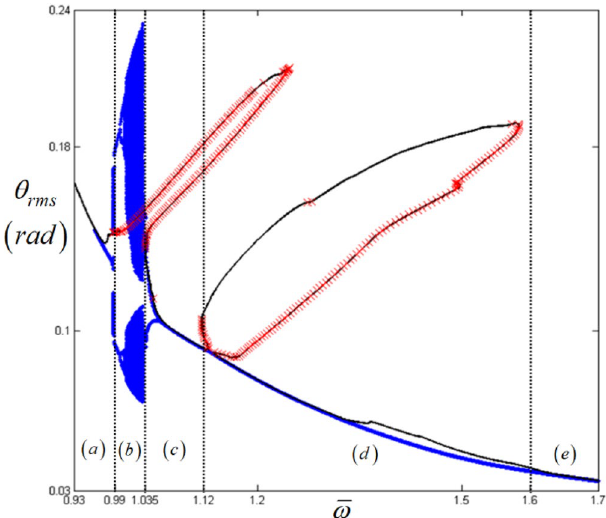
Figure 10. Comparison of HBM and bifurcation diagram with RMS values focused on super-harmonic resonances with the initial condition path (C): Key: Black line, HBM result with stable condition; Red times , HBM result with unstable condition; Blue circle, bifurcation diagrams.